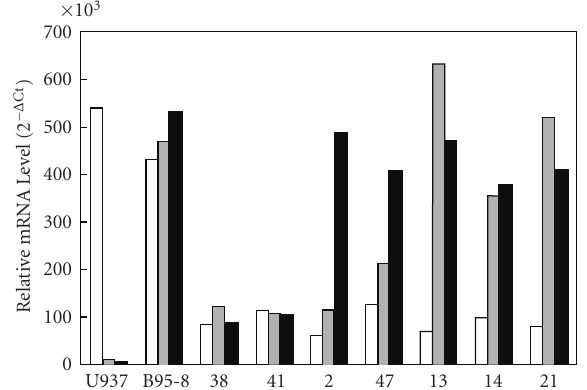
Figure 3: Quantitative real-time RT-PCR of the CD45, EBNA1, and EBNA2 transcripts in tumor samples. Due to the limited number of available frozen tissues, seven OSCC samples numbered 38, 41, 2, 47, 13, 14, and 21 (Case numbers are as those listed in Table 1), with the former two categorized as EBV-negative and others as positive, are used in this quantitative real-time PCR experiment. The portions in the frozen tissues applying to the experiments were all at positions adjacent to the respective tissue specimens used in the prior EBV-chip hybridizations. The results reveal that, after normalizing with the expression levels for the β -actin gene, the expressions of the gene for the pan-WBC surface marker CD45 in both the cell lines U937 and B95-8 are clearly detected, whereas they are low in all cancer samples, suggesting that EBV gene expression, if any, present in infiltrated blood cells does not contribute to the signals detected with EBV-chip. Tumor sample numbers 38 and 41 are EBV-negative (Table 3), samples 2 and 47 only express the great amounts of the EBNA2 gene transcript, and the rest of cases numbered 13, 14, and 21 have the strong expression signals for both the EBNA1 and EBNA2 genes. In conclusion, the data from the quantitative real-time RT-PCR analysis are in agreement with those shown in Figure 2. In here, two identical quantitative real-time PCR have been performed and very similar results are obtained. (cid:2) : CD45; : EBNA1; (cid:3) :